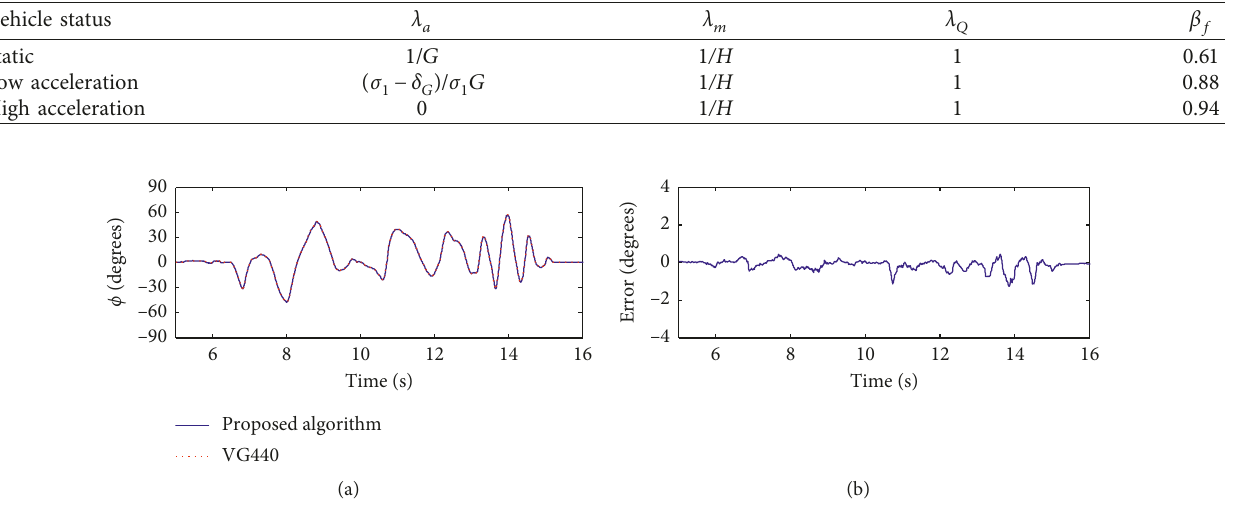
Figure 4: Roll angle: (a) comparison of the measured values; (b) errors.